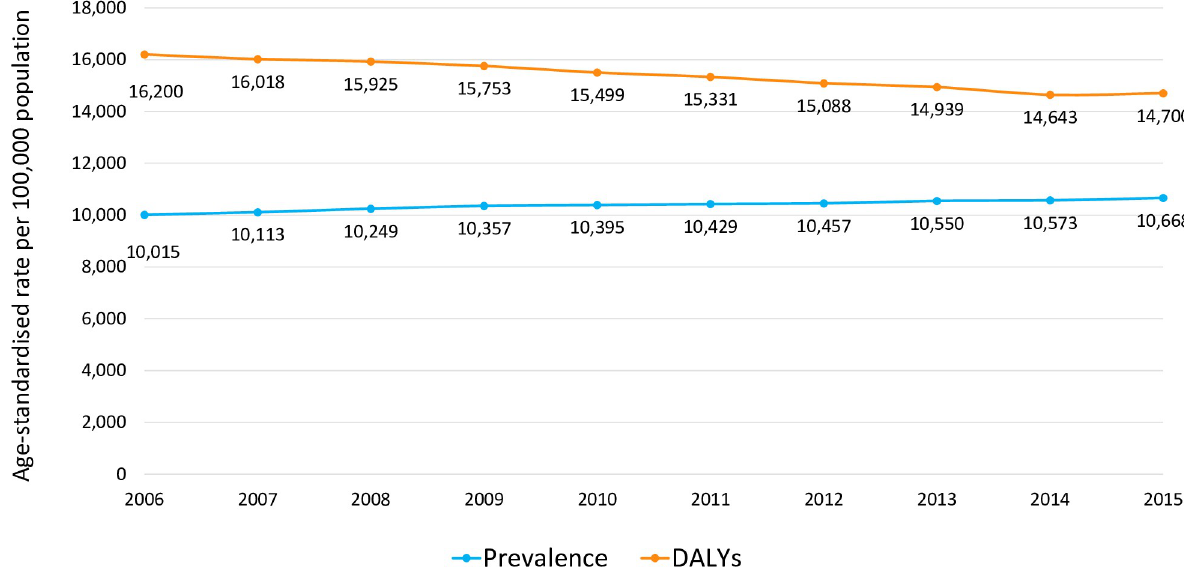
Fig 1. Cancer prevalence and DALYs lost due to cancer in France, Germany, Italy, Spain, UK (2006–2015). Age-standardised rate (ASR): a summary measure of the rate that a population would have if it had a standard age structure. Prevalence: number of current cases (new and pre- existing) at a specified time. Disability-adjusted life year (DALY): measure combining the burden of mortality and disability, calculated as the sum of the Years of Life Lost (YLL) due to premature mortality in the population and the Years Lost due to Disability (YLD) for people living with the health condition or its consequences.